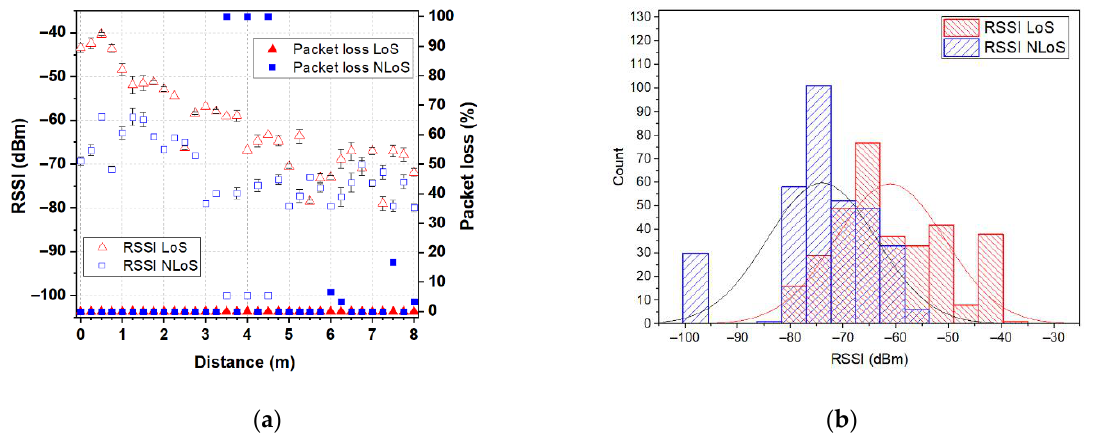
Figure 13. RSSI and packet loss for the backpack-integrated antenna prototype in the case of an empty backpack: ( a ) distributions with respect to the distance between the antennas; ( b ) histograms. The RSSI and packet loss for all positions in the LoS scenario are displayed with red triangles. The RSSI and packet loss for all positions in the NLoS scenario are displayed with blue squares.